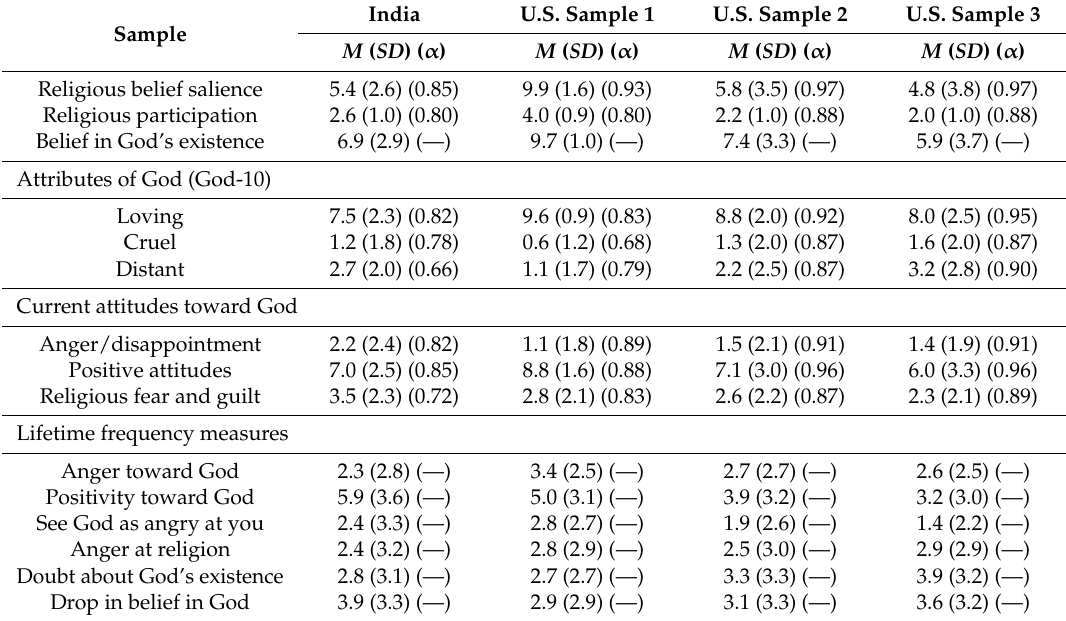
Table 1. Descriptive statistics for key